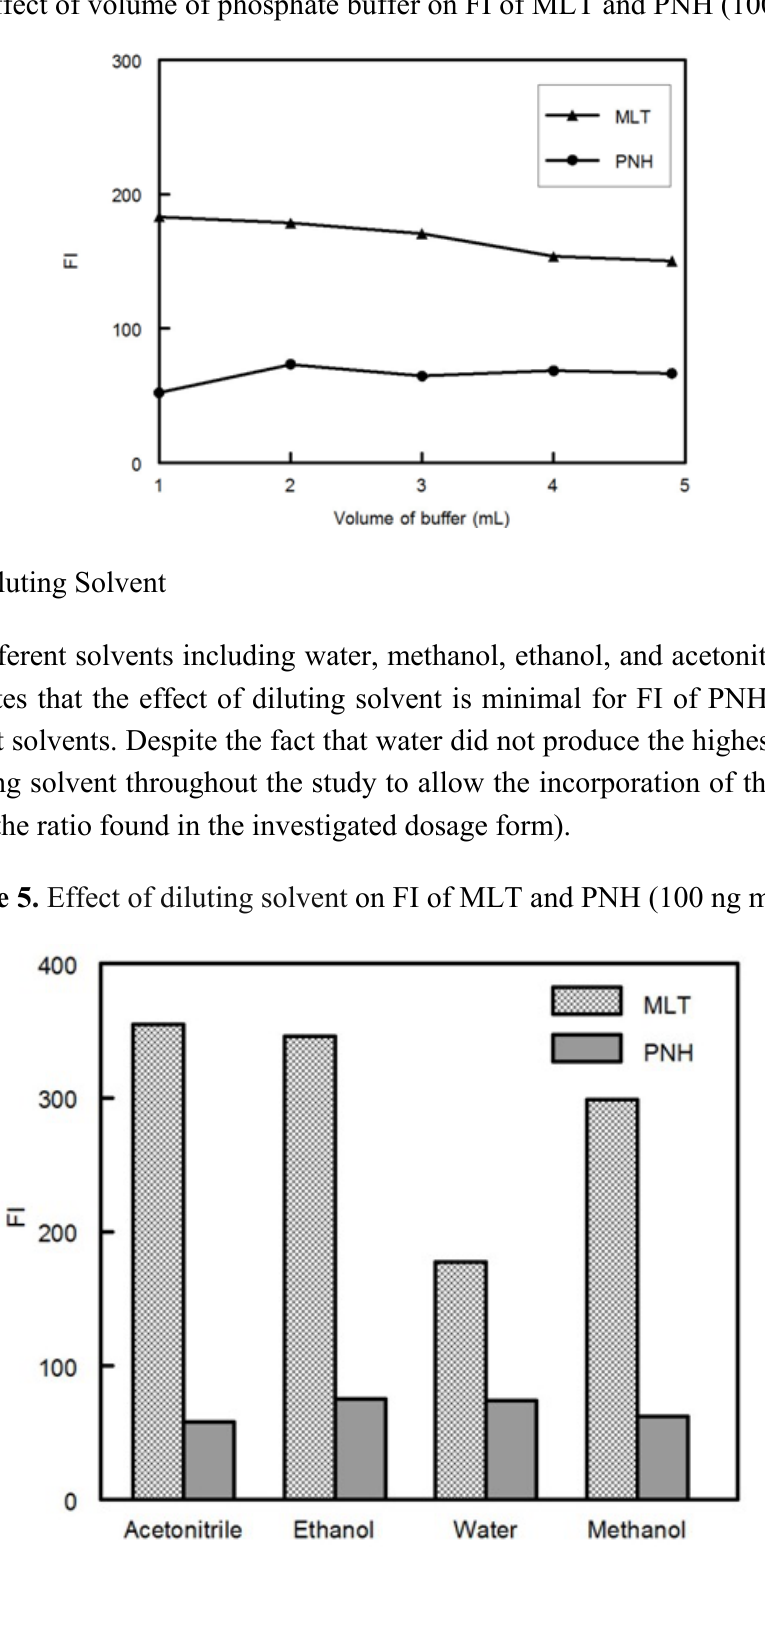
Figure 4. Effect of volume of phosphate buffer on FI of MLT and PNH (100 ng mL − 1 ).